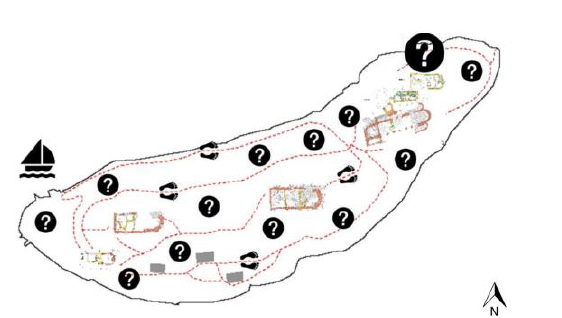
Fig. 2. Simplified plan of Isola Comacina with an indication of the most important structures. The “broken chain concept” is also illustrated: this research made a step towards their connection.